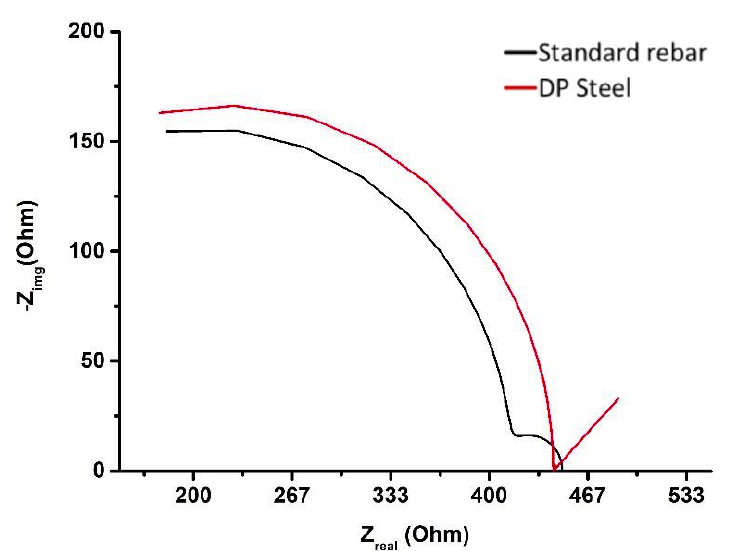
Figure 13. EIS results (Nyquist plots) for standard rebar and DP steel in 0.015 M NaHCO 3 + 0.005 M Na 2 CO 3 (pH = 9.0) solution.